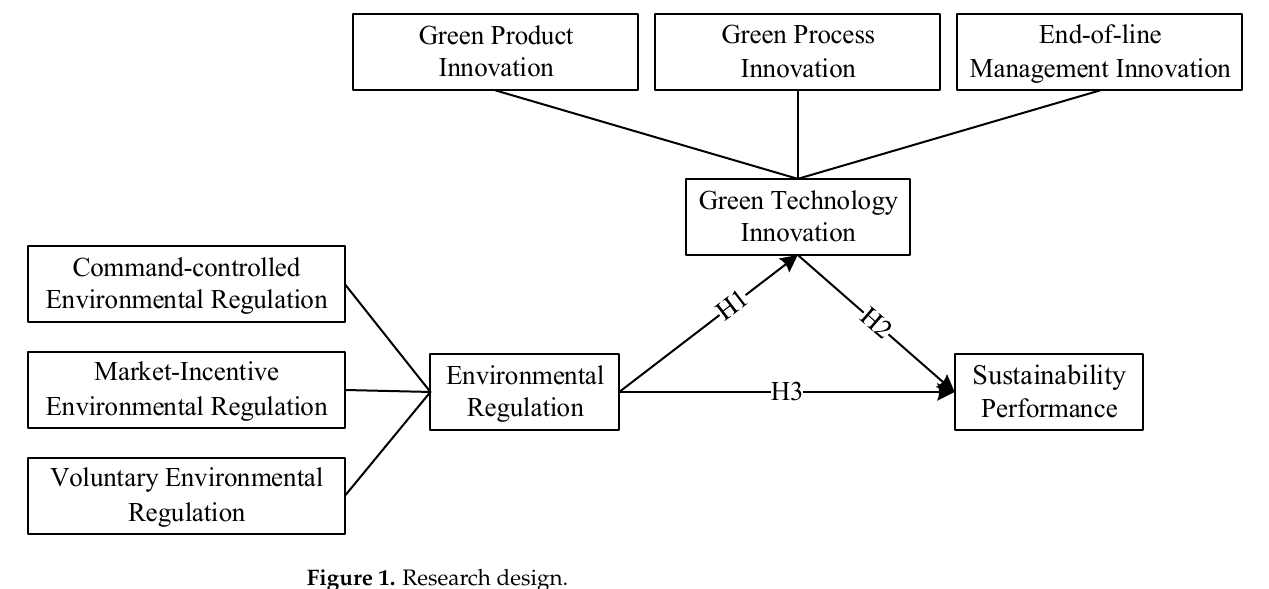
Figure 1. Research design.